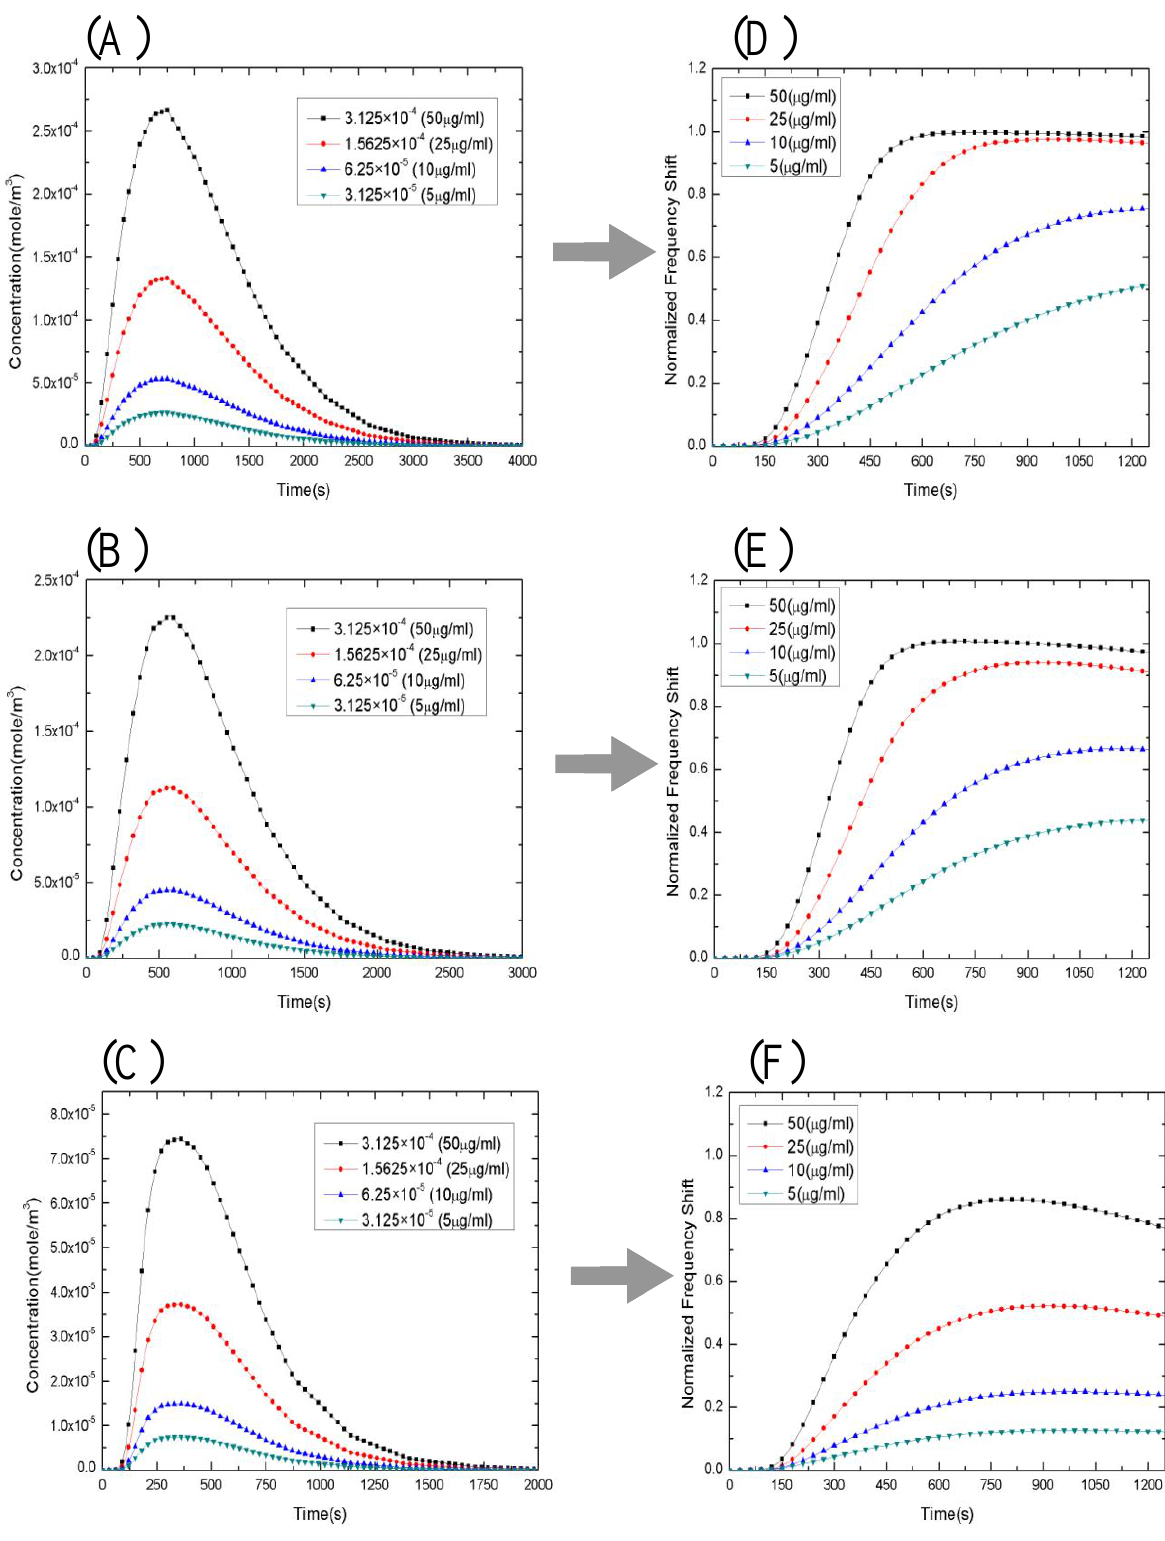
Figure 5. The distribution of the analyte concentration at the outlet of the tube, which is the inlet of the micro-channel, and the corresponding binding reaction